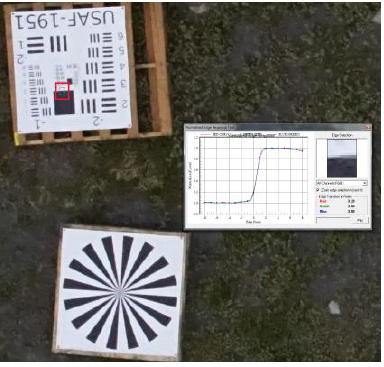
Figure 11: Normalized Edge Response Test